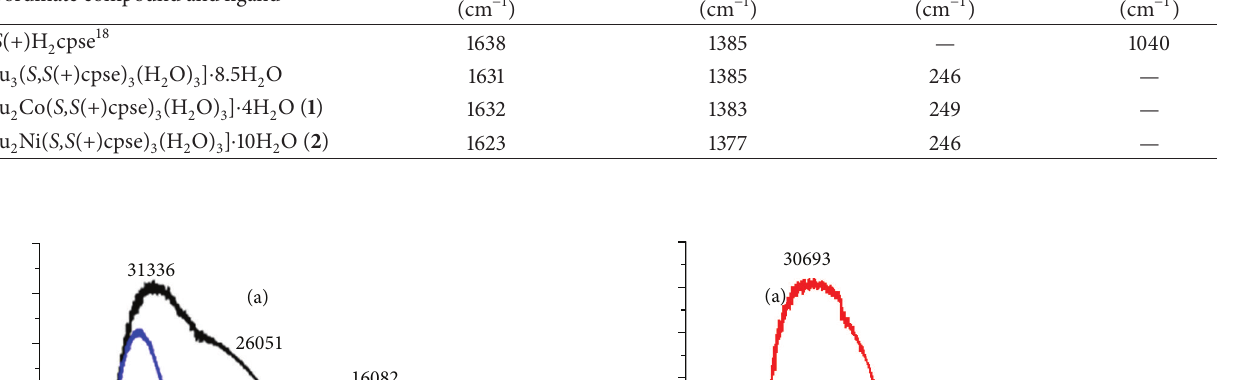
Table 1: Selected IR bands for the ligand and its coordination compounds. Coordinate compound and ligand